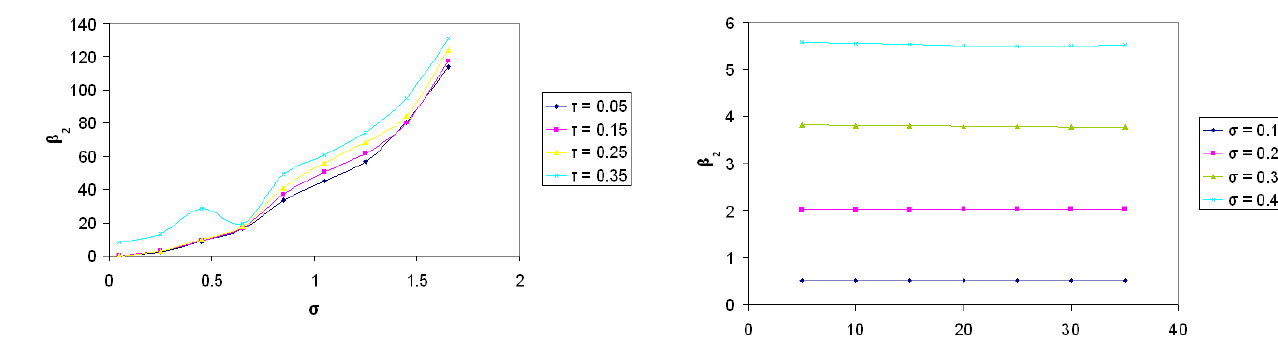
Figure 6. β 2 vs. σ .